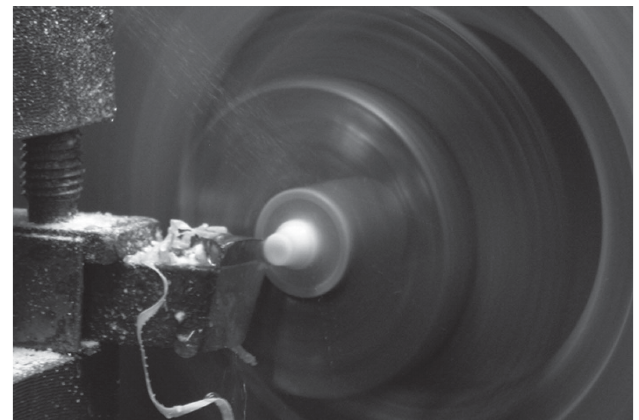
Fig. 1 - Preparation on mechanical lathe.